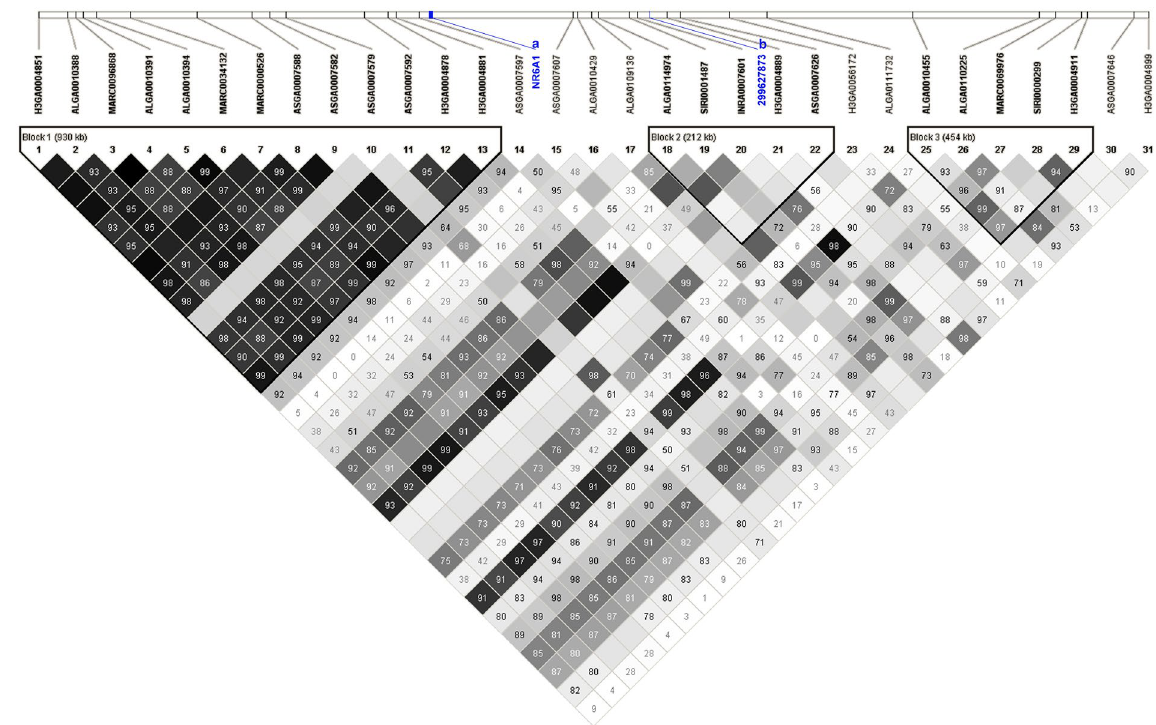
Figure 3. Haplotype block of a significant region (3 Mb) of SSC1 in Sutai pigs. The NR6A1 gene ( a ) did not fall into any block in this region, and the most significant position ( b ) was located at 299,627,873 bp in the 454 kb block